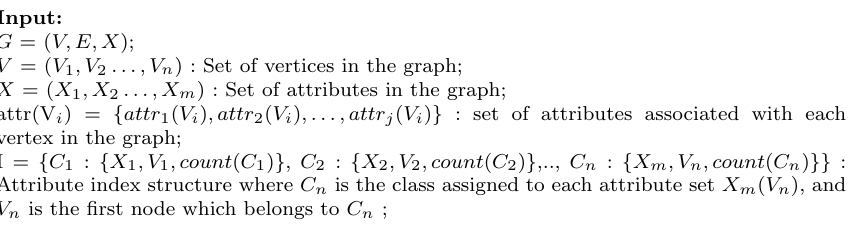
Algorithm 3 Generalized Community Detection